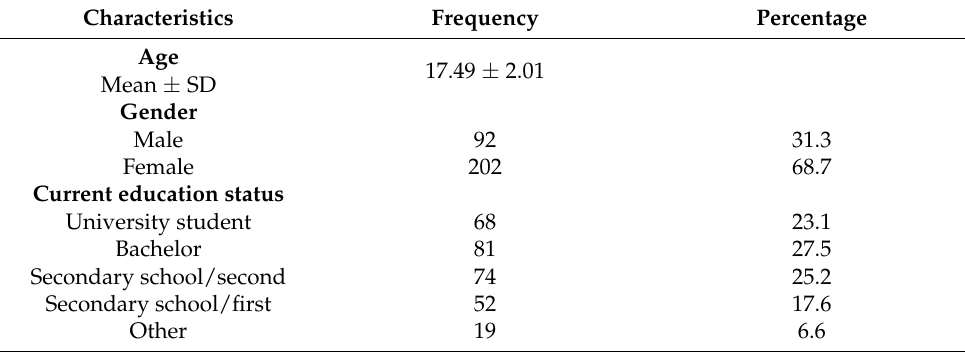
Table 1. Sociodemographic characteristics of the respondents.